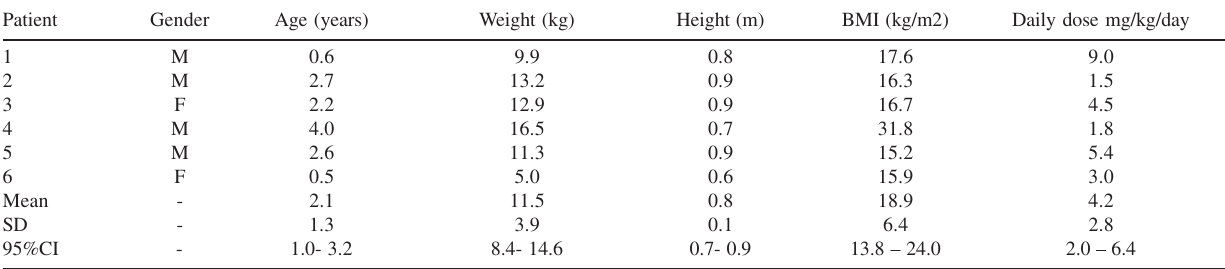
Table 1. Characteristics of the patients studied and daily dose of propranolol administered in the preoperative period.